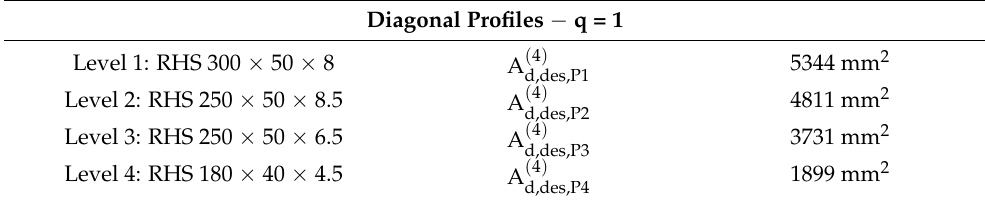
Table 9. Diagonal cross-sections of the multi-storey case study with structure factor equal to 1.